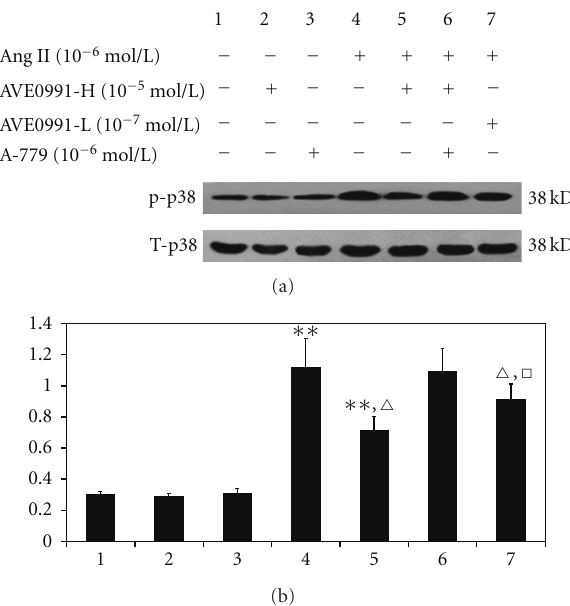
Figure 7: The e ff ect of AVE0991 on the p38 phosphorylation level in VSMCs that were induced by Ang II. Lanes 1–7 represent the control, AVE0991, A-779, Ang II, Ang II + AVE0991-H, Ang II + AVE0991-H + A-779, and the Ang II + AVE0991-L group. ∗∗ P < 0 . 01 versus control group; (cid:5) P < 0 . 01 versus Ang II group; (cid:2) P < 0 . 01 versus Ang II + AVE0991-H group; n = 8.